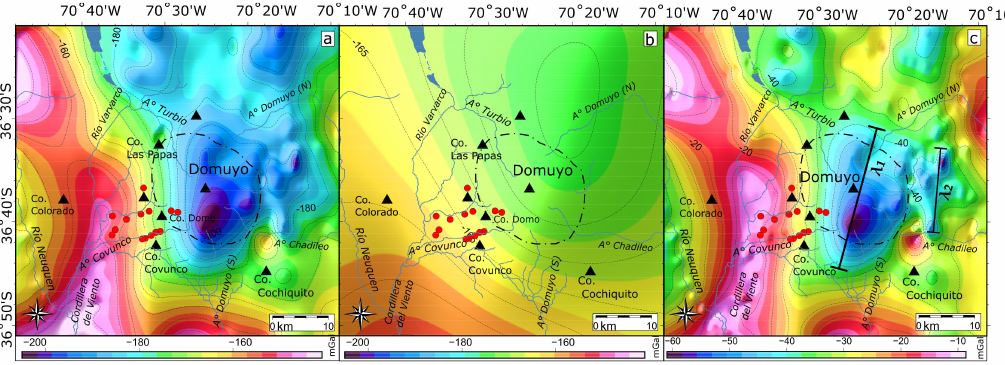
Figure 6. Bouguer anomaly map from terrestrial data. ( a ) Bouguer anomaly without filtering, ( b ) regional Bouguer anomaly from an upward continuation of 20 km, and ( c ) residual Bouguer anomaly map calculated by removing the fitted data (shown in panel b ) from the original data (shown in panel a ) calculated at 20 km depth. The wavelengths λ 1 and λ 2 indicate the two principal negative anomalies. These can be interpreted as the expressions of fluid-bearing reservoirs at depth. Red dots correspond to thermal activity. The black dashed line corresponds to the deformed area identified from the InSAR data, and the black triangles show the main mountain